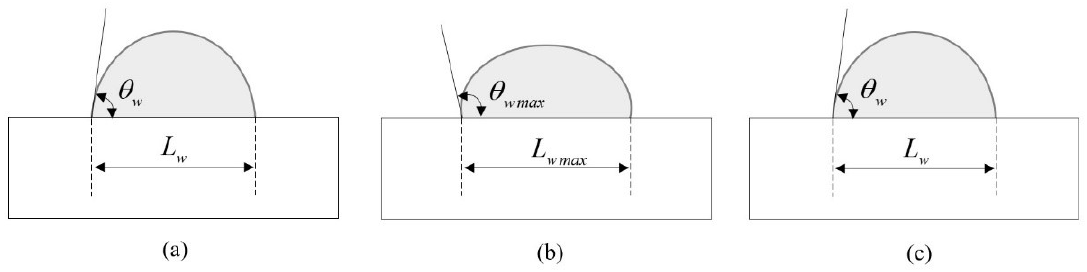
Figure 10. The width and contact angle of molten pool section.( a ) Early stage of single cycle; ( b ) Mid- dle stage of single cycle; ( c ) Late stage of single